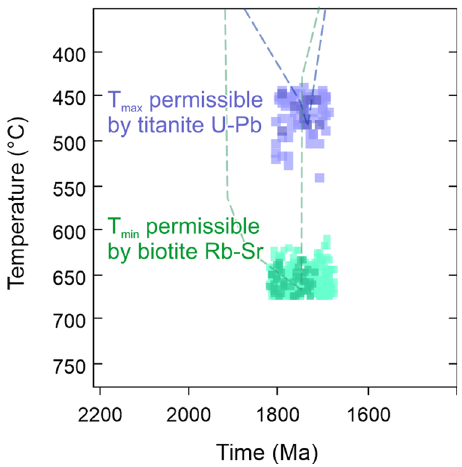
Fig. 10 Time-temperature evolution models. Thermal history models constrain the maximum permissible temperature to leave titanite unreset (blue squares) yet entirely thermally reset biotite (green squares). The difference in calculated temperature implies that biotite Rb – Sr re fl ects a neoblastic